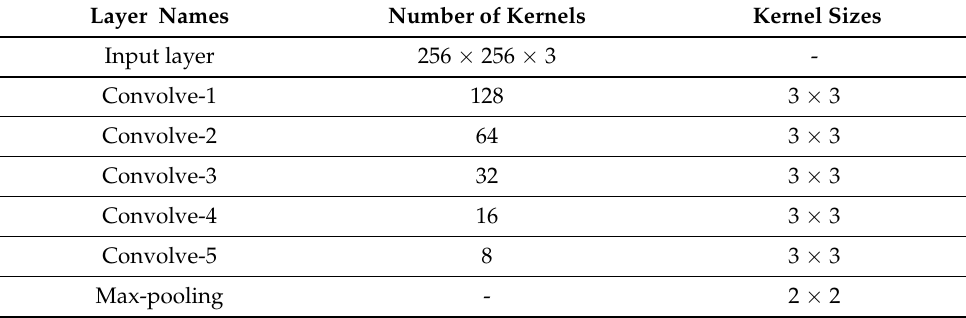
Table 3. Convolution layers’ description of proposed